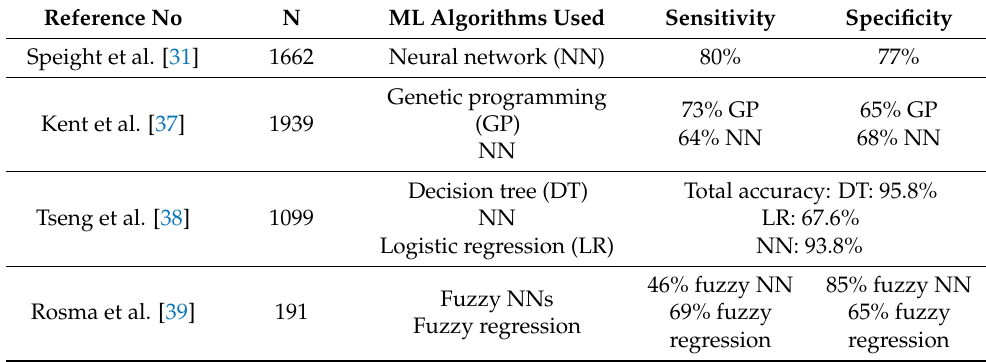
Table 2. Performance metrics for various studies that used machine learning algorithms. Reference No N ML Algorithms Used Sensitivity